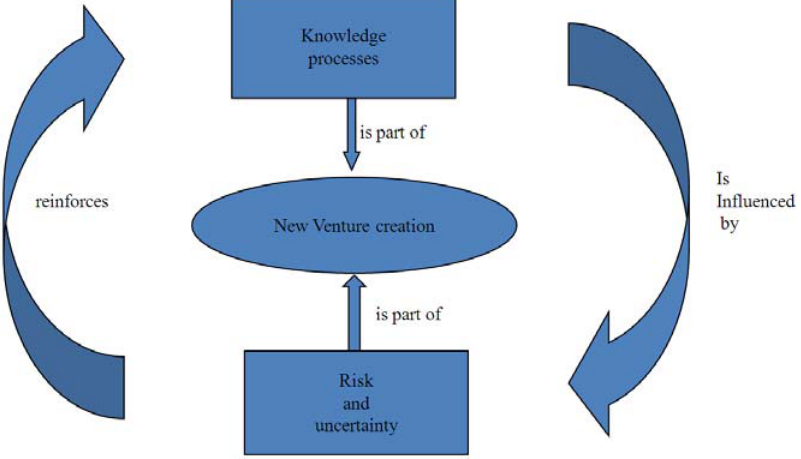
Fig. 1. The entrepreneurial